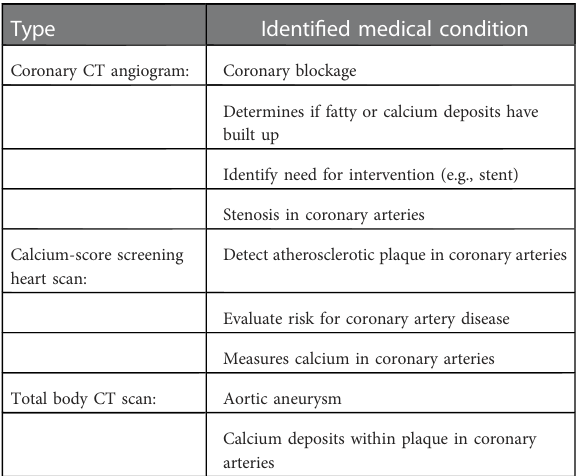
TABLE 4 Types of CT scanning technologies and the identi fi ed medical